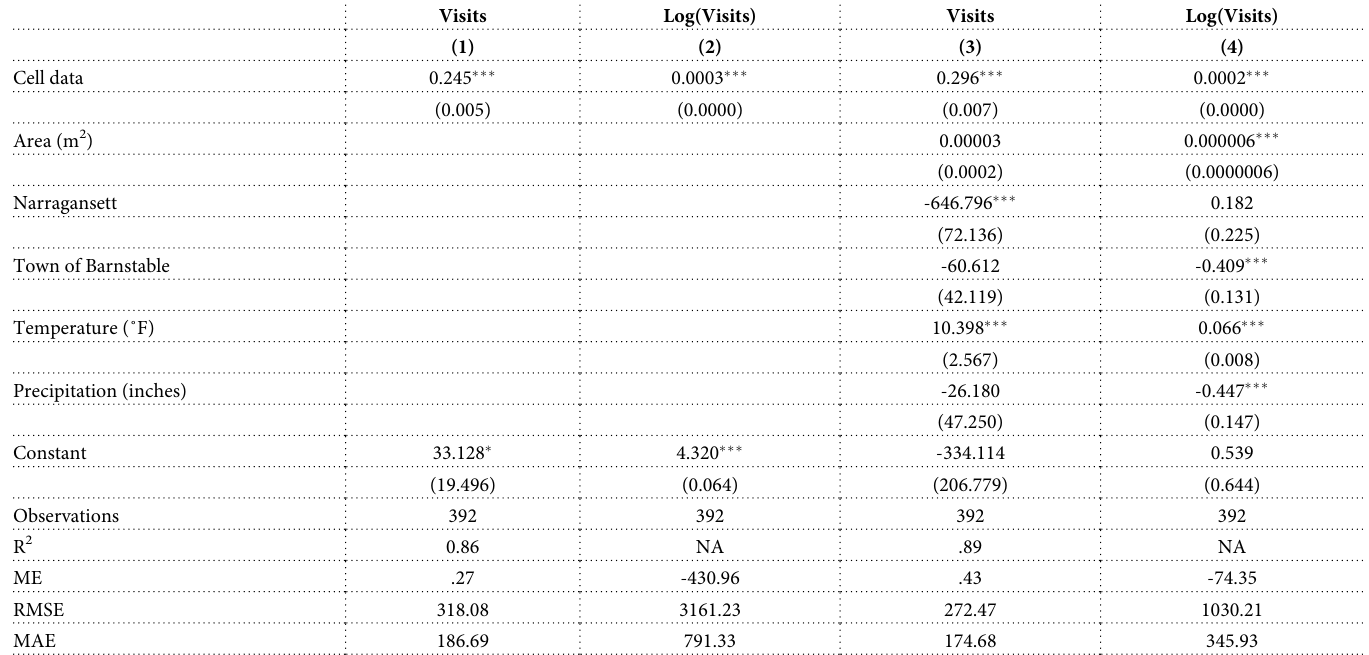
Table 2. Regression results.